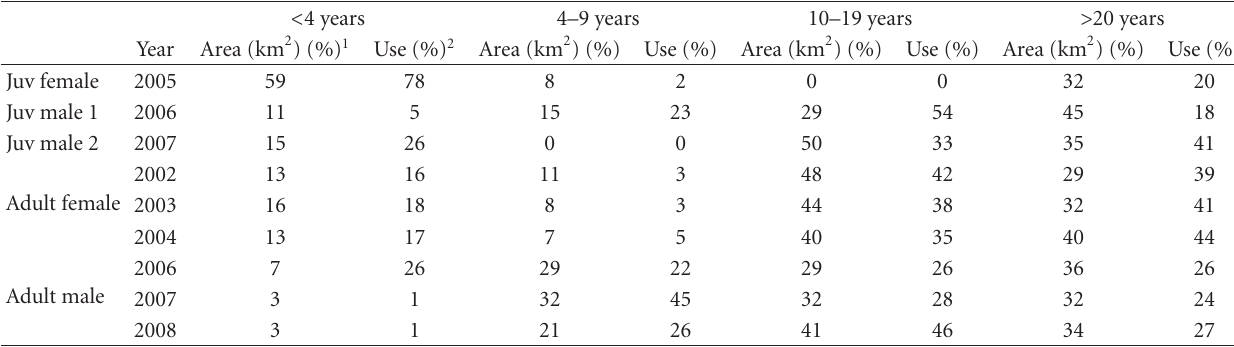
Table 2: Falcon use of compartments by age category.